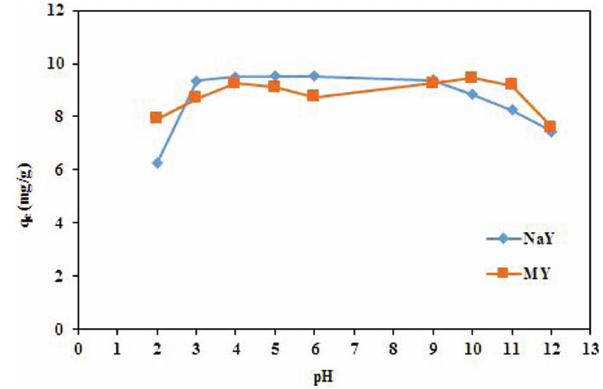
Figure 8: Effect of pH on equilibrium uptake of MB (m = 0.01 g, V = 0.01 L, C = 10 mg/L, T = 20°C, stirring rate = 250 0